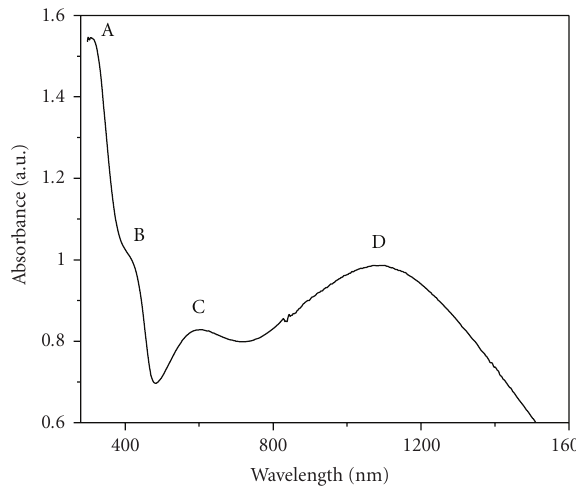
Figure 2: Optical absorption spectra of PANI-co-POT thin